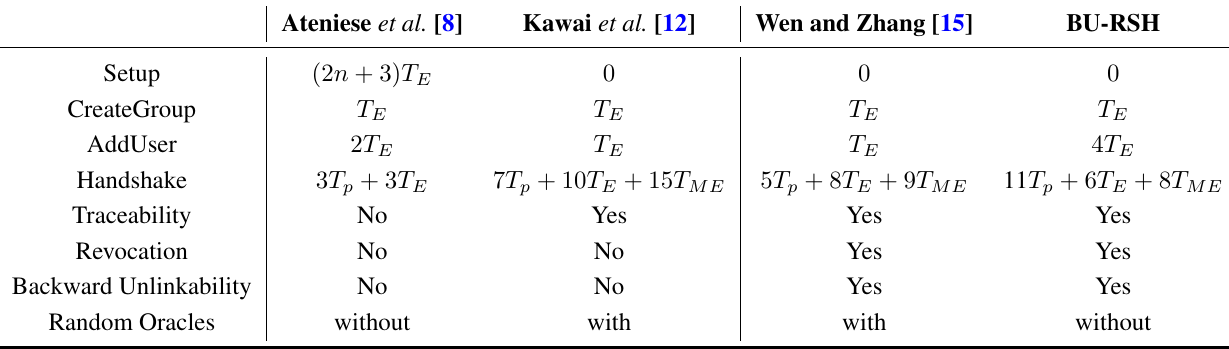
Table 1. A comparison of related secret handshake schemes. BU-RSH, backward unlinkable secret handshake scheme with revocation